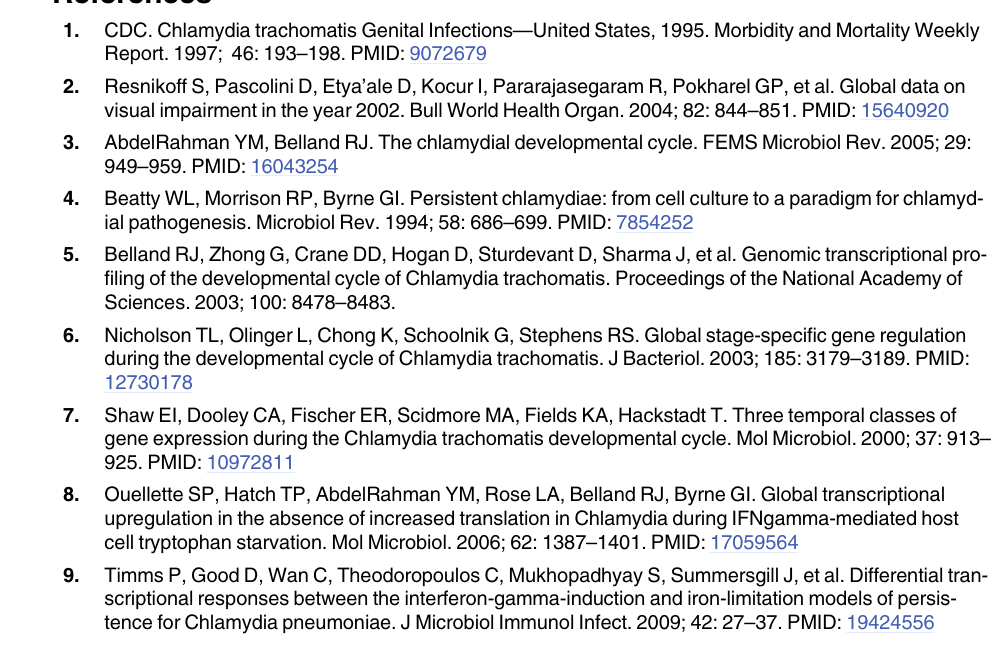
S10 Fig. Inclusion size is altered upon ectopic RsbV1 expression. Chlamydia trachomatis morphology was examined in L2/25667R transformed strains harboring pCT308-GFP, pCT1310-RsbW, or pCT1310-RsbV1 (A). Samples were fixed at 28 hours post infection and images were captured using Leica SP5 confocal microscope in both red (DyLight-594 immuno- labeled Chlamydia ) and green (endogenous GFP expression) channels. Inclusions representa- tive of the mean inclusion area are shown. Scale bars represent 10 μ m. Box and Whisker plots representing inclusion area from confocal micrographs are shown in (B). Each box represents the upper/lower quartiles transected by the median inclusion size. Whiskers represent the 5 – 95% confidence interval, and (+) represent the mean of each group. Statistical p values are derived from One-way ANOVA with Tukey ’ s multiple comparison post-test ( (cid:1)(cid:1)(cid:1)(cid:1) represents p <